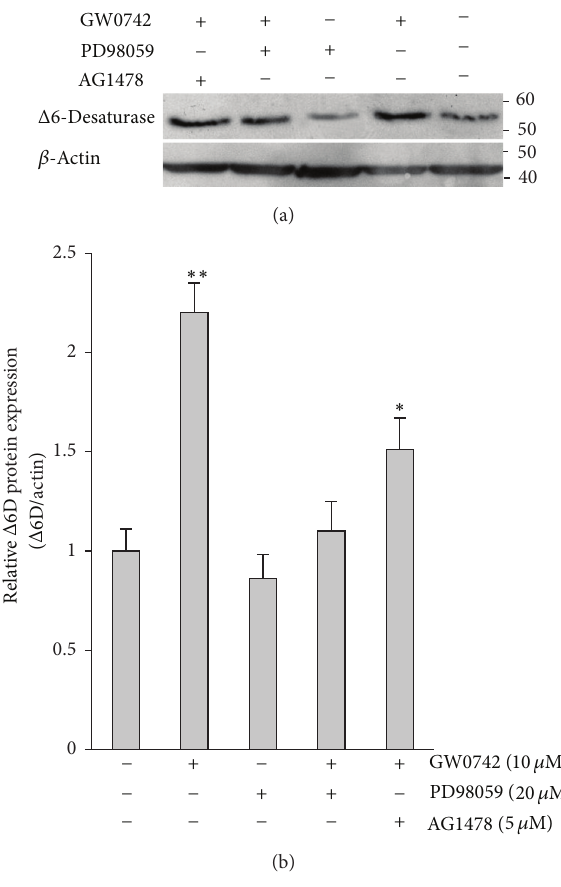
Figure 2: Effects of the PPAR 𝛿 agonist, selective inhibitor of MEK/ERK1/2, and EGF receptor-selective tyrosine kinase inhibitor on mRNA expression of Δ 6-desaturase ( Δ 6D) in PANC-1 human pancreatic tumor cells. Cells were treated with GW0742, PD98059, or AG1478 as indicated. One microgram of extracted RNA was reverse transcribed, and real-time RT-PCR to amplify Δ 6 desaturase and GAPDH cDNA fragments was performed as described. Relative expression with duplicate samples is given and was calculated by normalization to GAPDH and represented as mean ± SE from 3 independent experiments. ∗ and ∗∗ : 𝑃 < 0.05 and 𝑃 < 0.01 for Student’s 𝑡 -test, respectively.